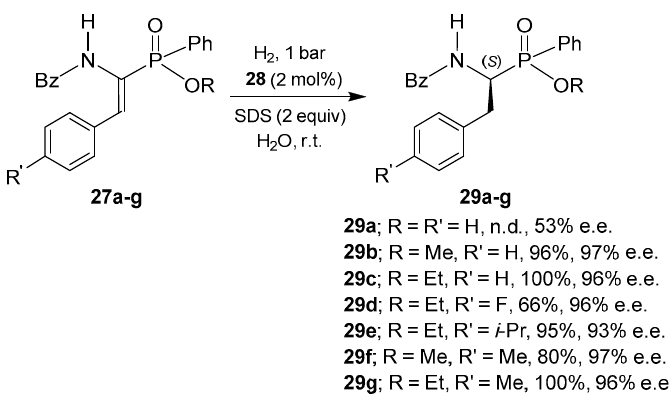
Scheme 19. Optimized conditions for the catalytic hydrogenation of 27a – g .